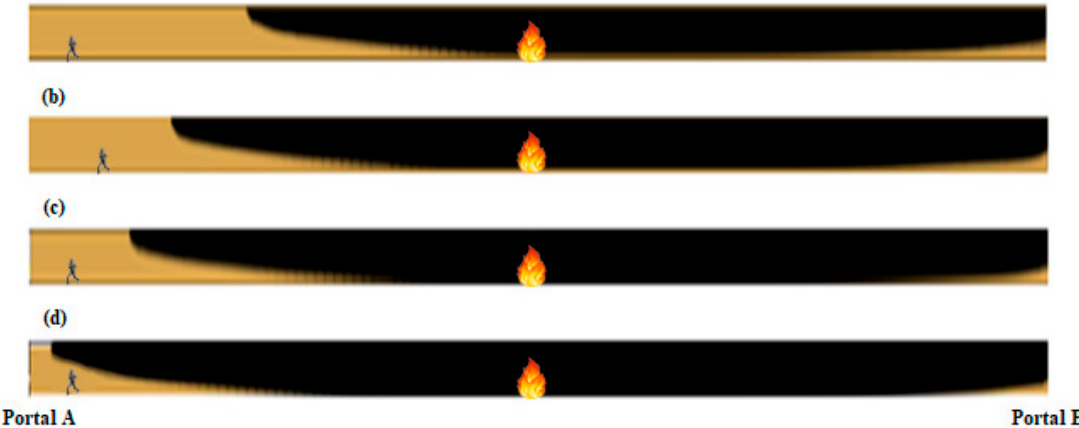
Figure 9. Contours of smoke propagation within the tunnel investigated, after 10 min from the start of fire, when the burning vehicle is in the middle of the tunnel length: ( a ) 8 MW; ( b ) 30 MW; ( c ) 50 MW; ( d ) 100 MW.